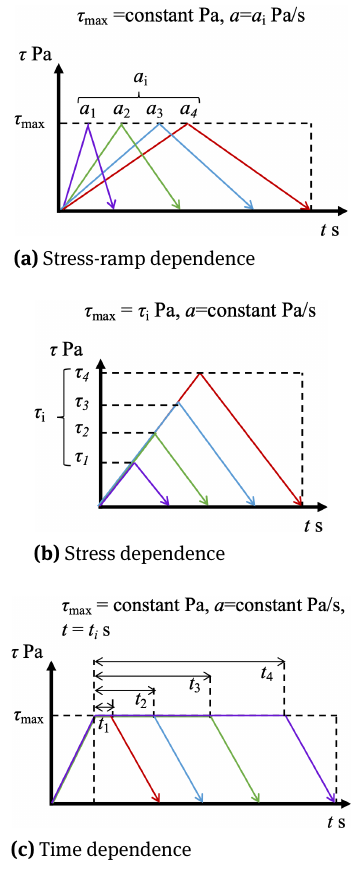
Figure 6: Three sequences for evaluating various